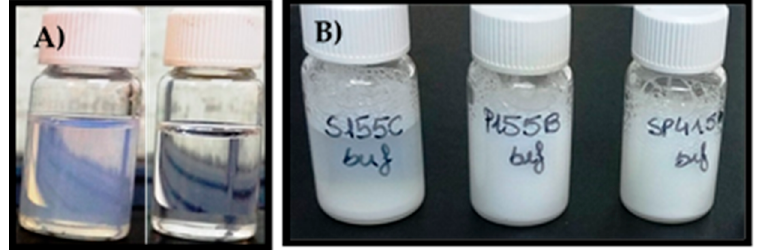
Figure 4. Appearance of ( A ) Soluplus 10% (left) and Pluronic P103 10% (right) dispersions in 0.9% NaCl; ( B ) Poly(pseudo)rotaxane formation after the addition of 10% α CD to Soluplus (left), Soluplus/Pluronic P103 in ratio (4:1) (in the middle), and Pluronic P103 dispersions (right) in pH 6.4 buffer after storage for 12 h at room temperature.